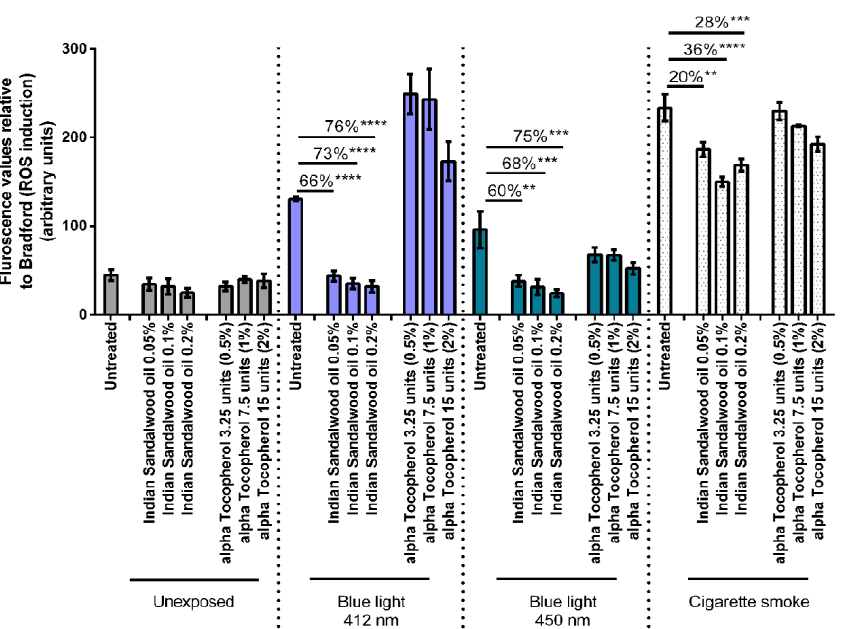
Figure 4. Assessment of ROS induced after exposure of HaCaT cells to blue light at 412 nm (1 J/cm 2 ), blue light at 450 nm (1 J/cm 2 ), and cigarette smoke. The figure is representative of three independent experiments performed, and for each run, the samples were tested in triplicates. The values represent the fluorescence relative to the Bradford values (mean ± SEM). ** represents p value < 0.01; *** represents p value < 0.001; **** represents p value < 0.0001.